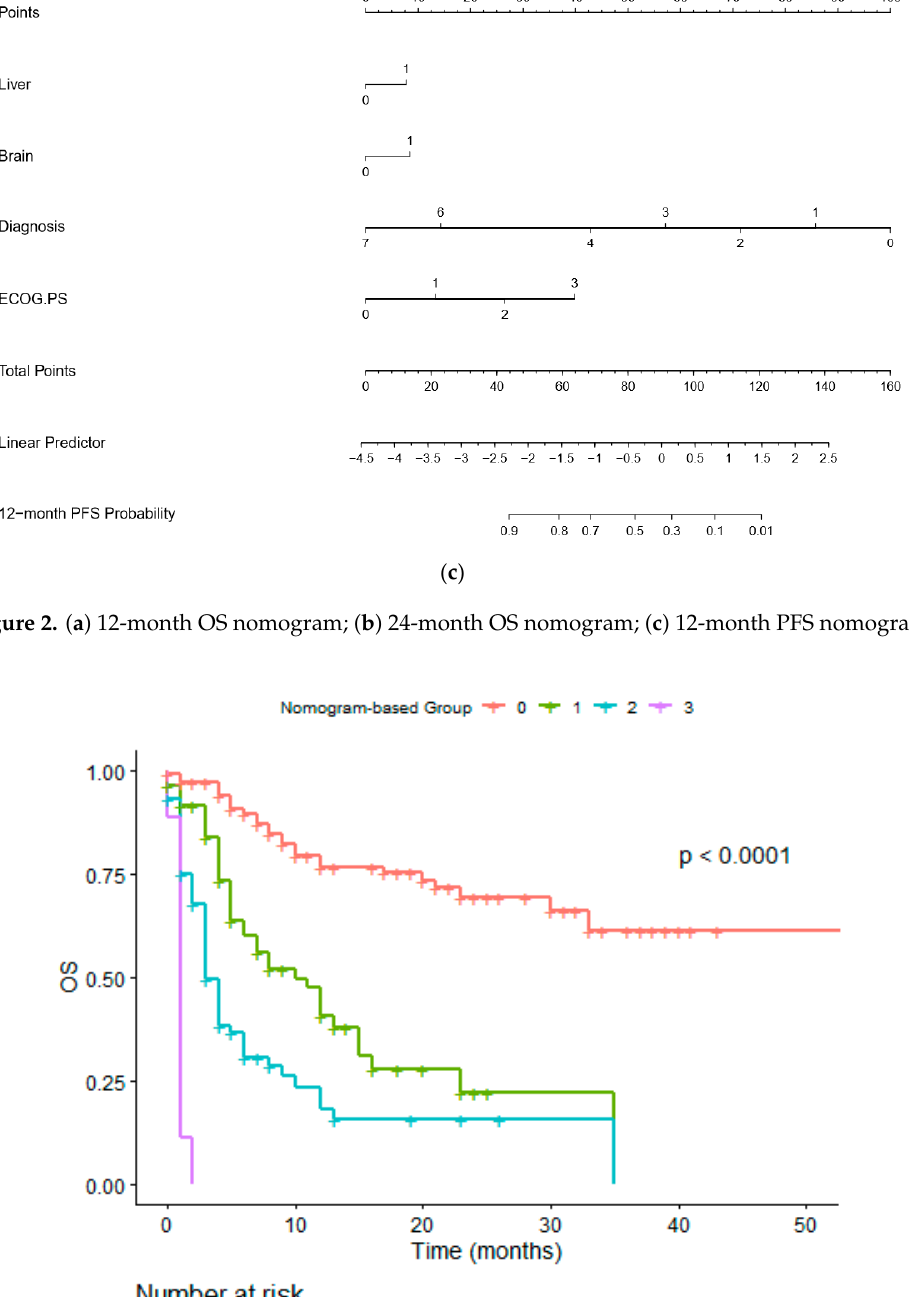
Figure 3. OS in nomogram-based groups.